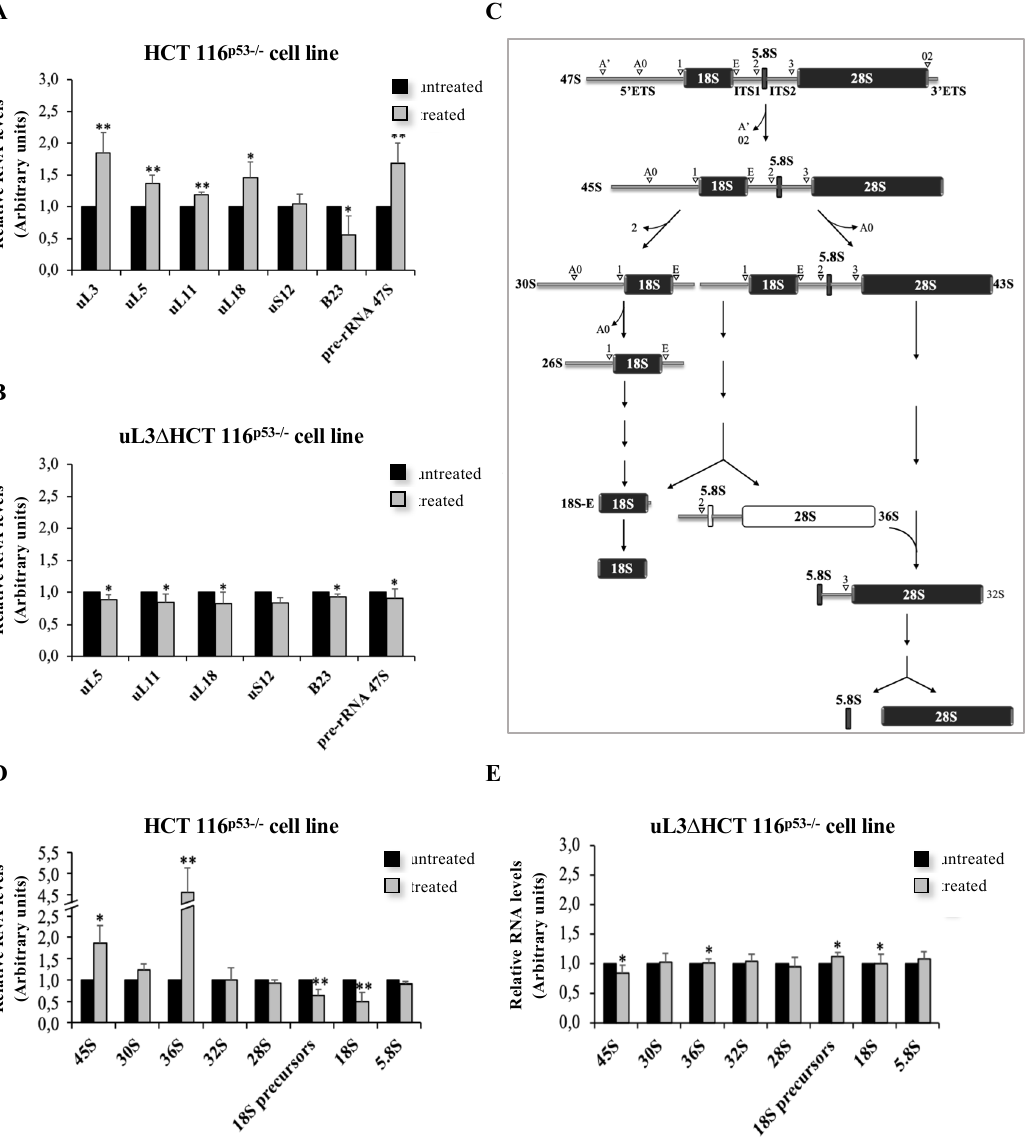
Figure 3. LQ1 treatment induces nucleolar stress and impairs rRNA processing. Total RNA from HCT 116 p53 − / − ( A ) and uL3 ∆ HCT 116 p53 − / − ( B ) cells, untreated or treated with 10 µ M of LQ1 for 48 h, was subjected to RT–qPCR with primers specific for indicated genes (Table 2). Quantification of signals is shown. Bars represent the mean of triplicate experiments; error bars represent the standard deviation. * p < 0.05, ** p < 0.01 vs. untreated cells set at 1. ( C ) Schematic representation of 47S rRNA maturation process. Cleavage sites are indicated with white arrows. Relative expression levels of rRNA, from HCT 116 p53 − / − ( D ) and uL3 ∆ HCT 116 p53 − / − ( E ) cells, untreated or treated with 10 µ M of LQ1 for 48 h analyzed by RT–qPCR with primers specific for intermediates and mature rRNAs (Table 2). Bars represent the mean of triplicate experiments; error bars represent the standard